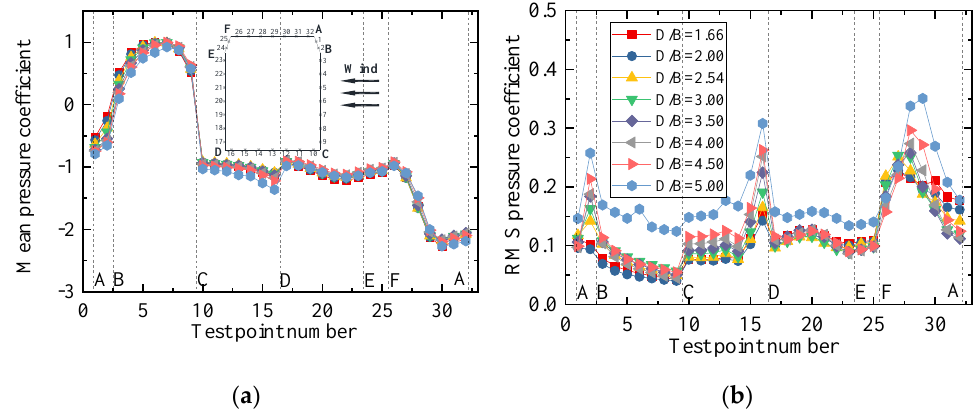
The results of the three-component coefficients of the upstream bridge are plotted in Figure 17. The interference factor of the lift coefficient is not presented in the diagram, since the lift coefficient of the upstream bridge in Case 3 was close to zero. The drag coef- ficient showed a decreasing trend, while the lift and moment coefficients increased slightly as the D/B increased. Generally, the three-component force coefficients of the up- stream bridge were less affected by the D/B ratio. The interference factor of the drag coef- ficient was always less than unity, illustrating that the aerodynamic interference of the upstream bridge was weaker and the drag coefficient decreased when the vehicle was located on the leeward side such as in Case 3.